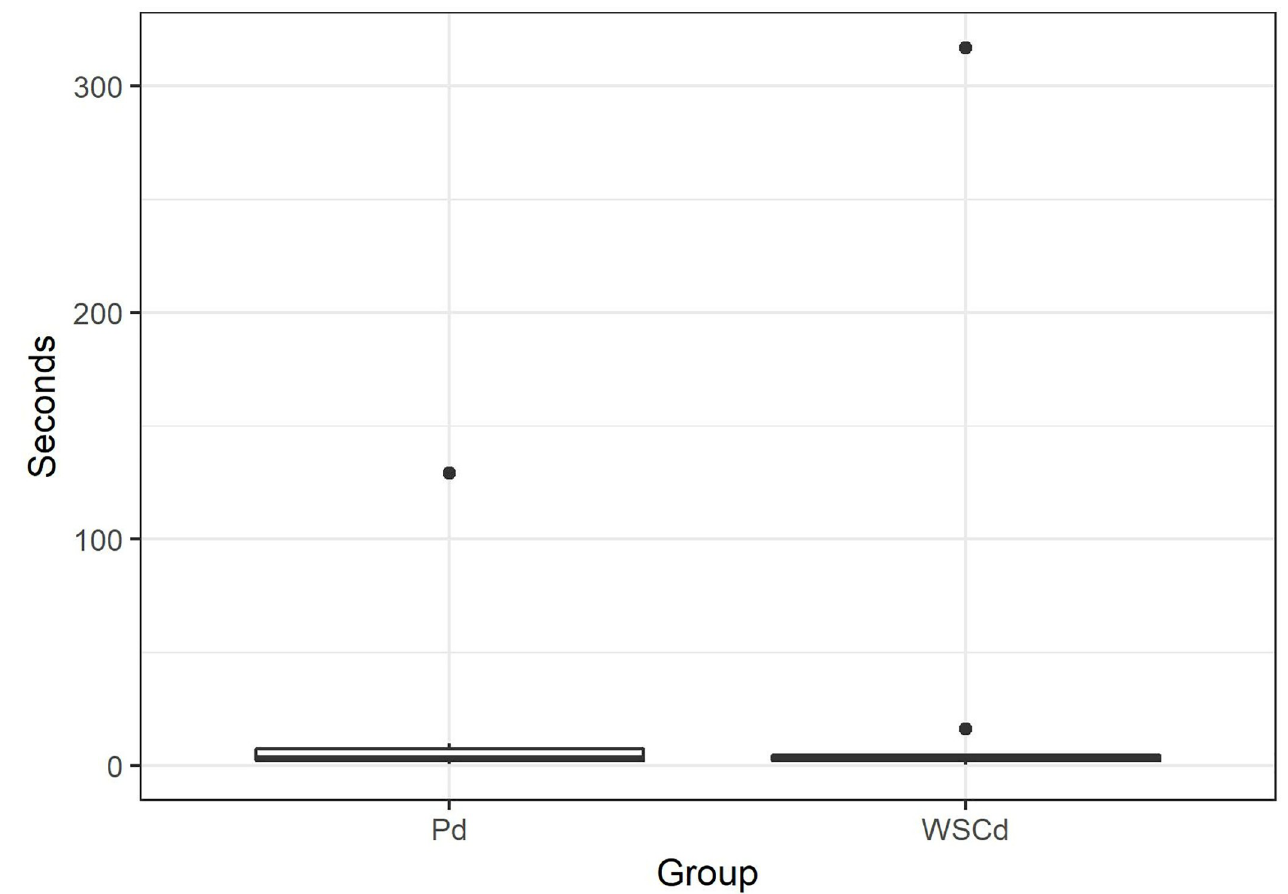
Fig 5. Duration of manipulation of the ball for pet dogs (Pd) and WSC dogs (WSCd).